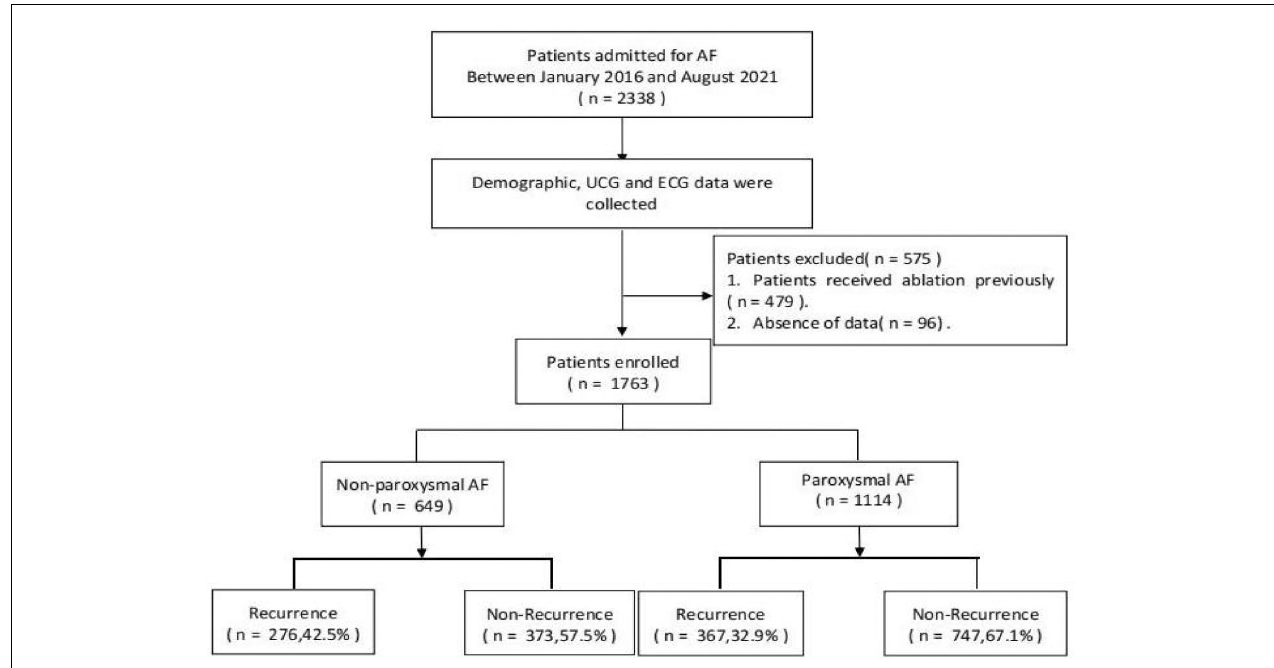
FIGURE 1 | The overview of the selection of study participants.